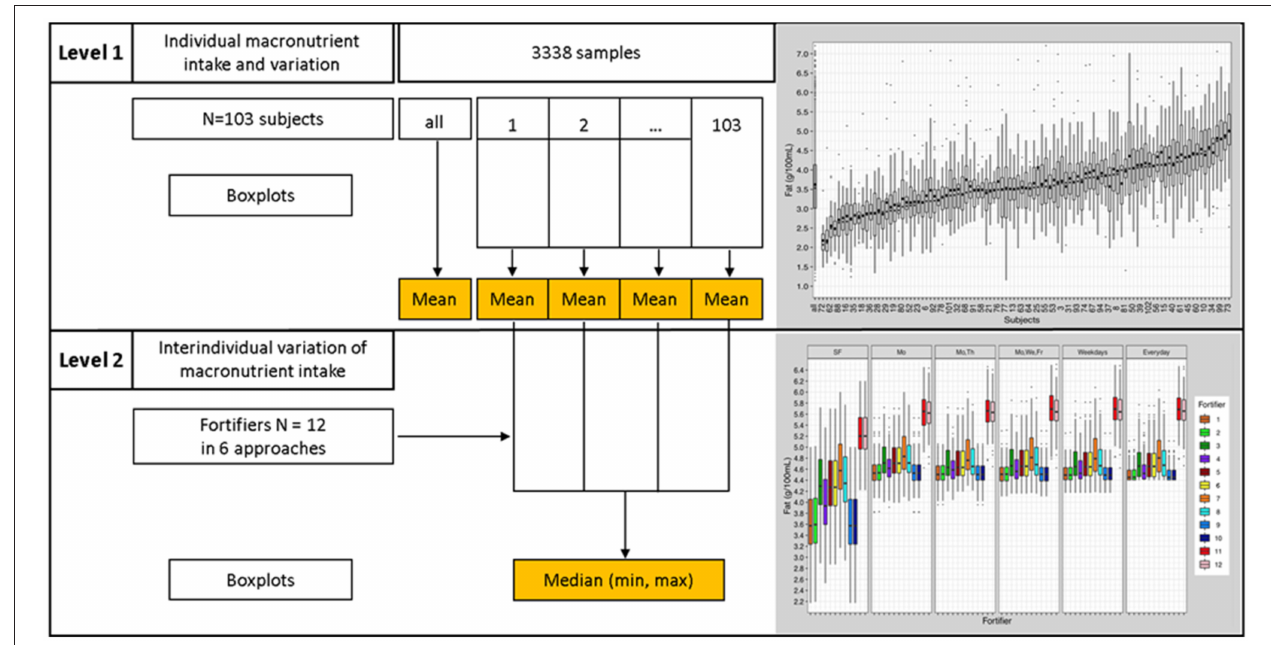
FIGURE 4 | Statistical analyses process; Level 1 analysis—presentation of individual data, Level 2 analysis—inter-individual comparison.